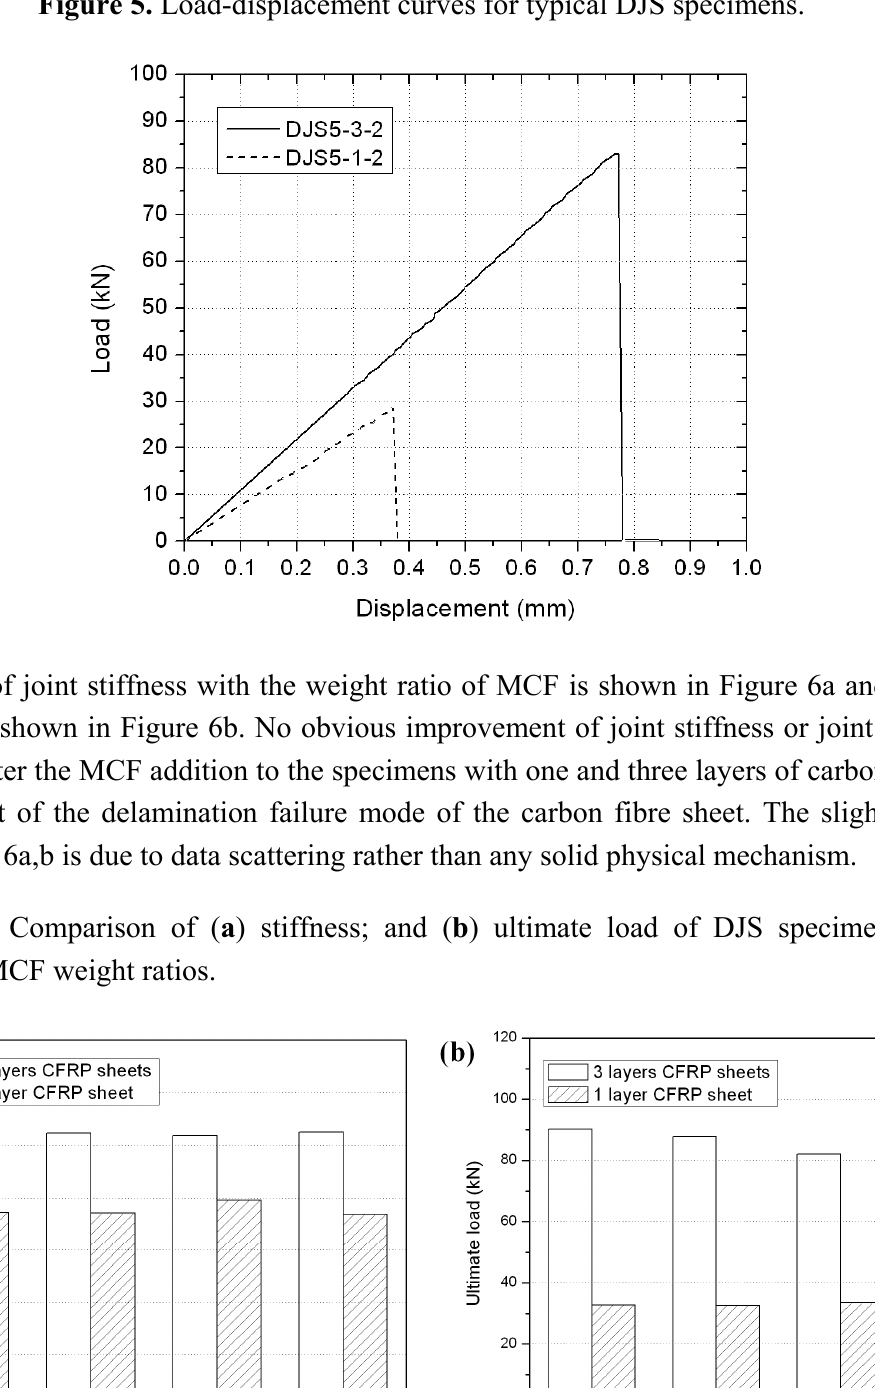
Figure 5. Load-displacement curves for typical DJS specimens.